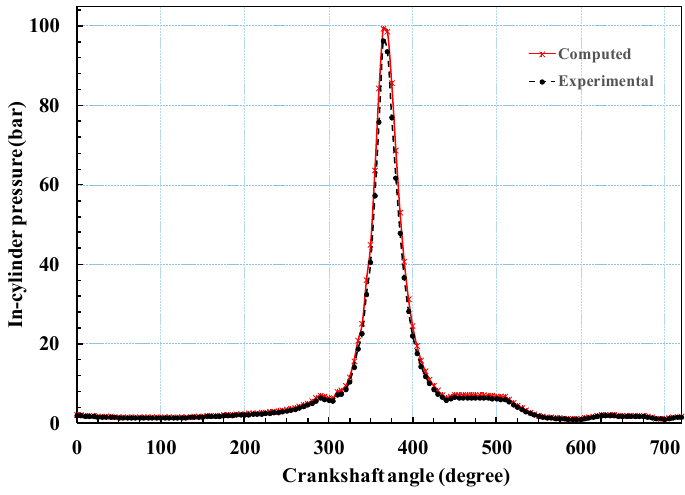
Figure 3. The in-cylinder pressure profile using the experimental and numerical methods.